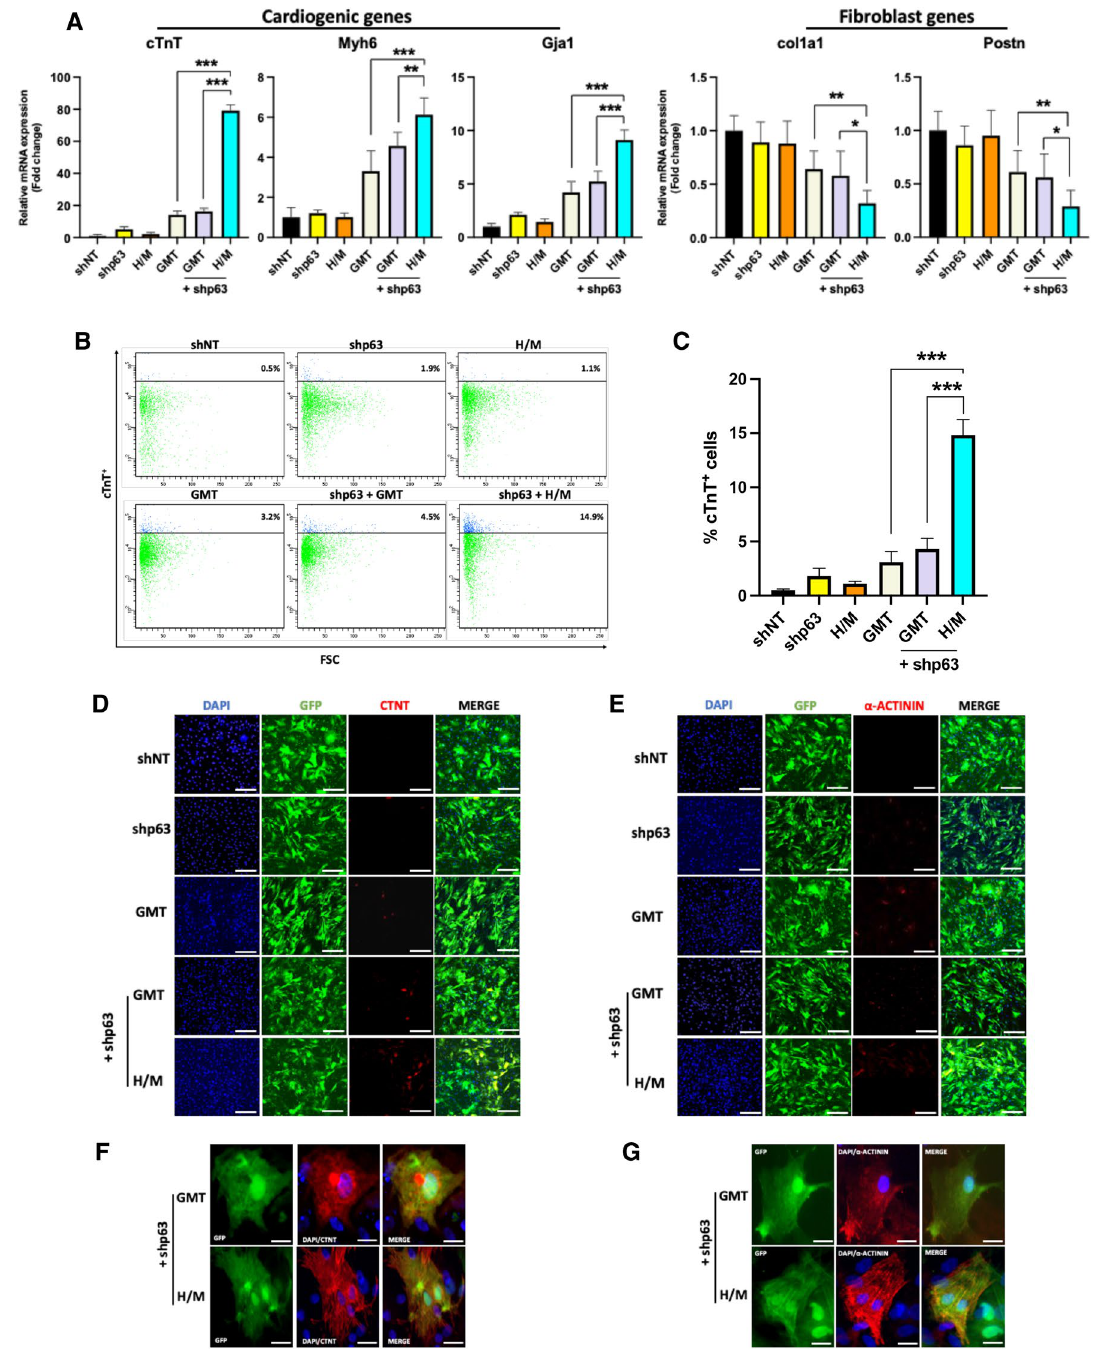
Figure 2. p63 silencing in combination with Hand2/Myocardin enhances human cardiac reprogramming. ( A ) Cardiomyocyte and fibroblast marker gene expression assessed by qRT ‐ PCR (n = 3, ***p < 0.001, **p < 0.01, *p < 0.05), shNT short hairpin non-targeting. ( B ) Representative flow cytometry plots for cardiac troponin T positive (cTnT + ) human cardiac fibroblasts 2 weeks after their treatment with shp63 with or without Hand2/Myocardin (H/M) versus GMT) with or without shp63. ( C ) Quantification of the percentage of cTnT + cells treated as indicated, as assessed by flow cytometry (n = 3; ***p < 0.001). ( D,E ) Representative immunofluorescence staining for 4 ʹ ,6 ‐ diamidino ‐ 2 ‐ phenylindole (DAPI) (blue), GFP (green), and (red) cardiomyocyte markers cTnT ( D ) and α ‐ actinin ( E ) after 2 weeks. Scale bar = 100 μm. ( F,G ) Representative high magnification images of immunofluorescence staining for cTnT ( F ) and α-actinin ( G ) after 4 weeks of shp63+ H/M transduction demonstrating sarcomeric structures, most clearly visible in α-actinin labeled cells. Scale bar: 25